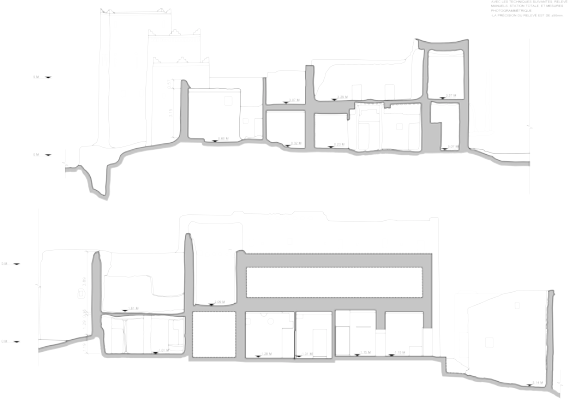
Figure 7: resulting cross section, product of orthographic images using photogrammetry, EDM Total Station survey and overlay using CAD.